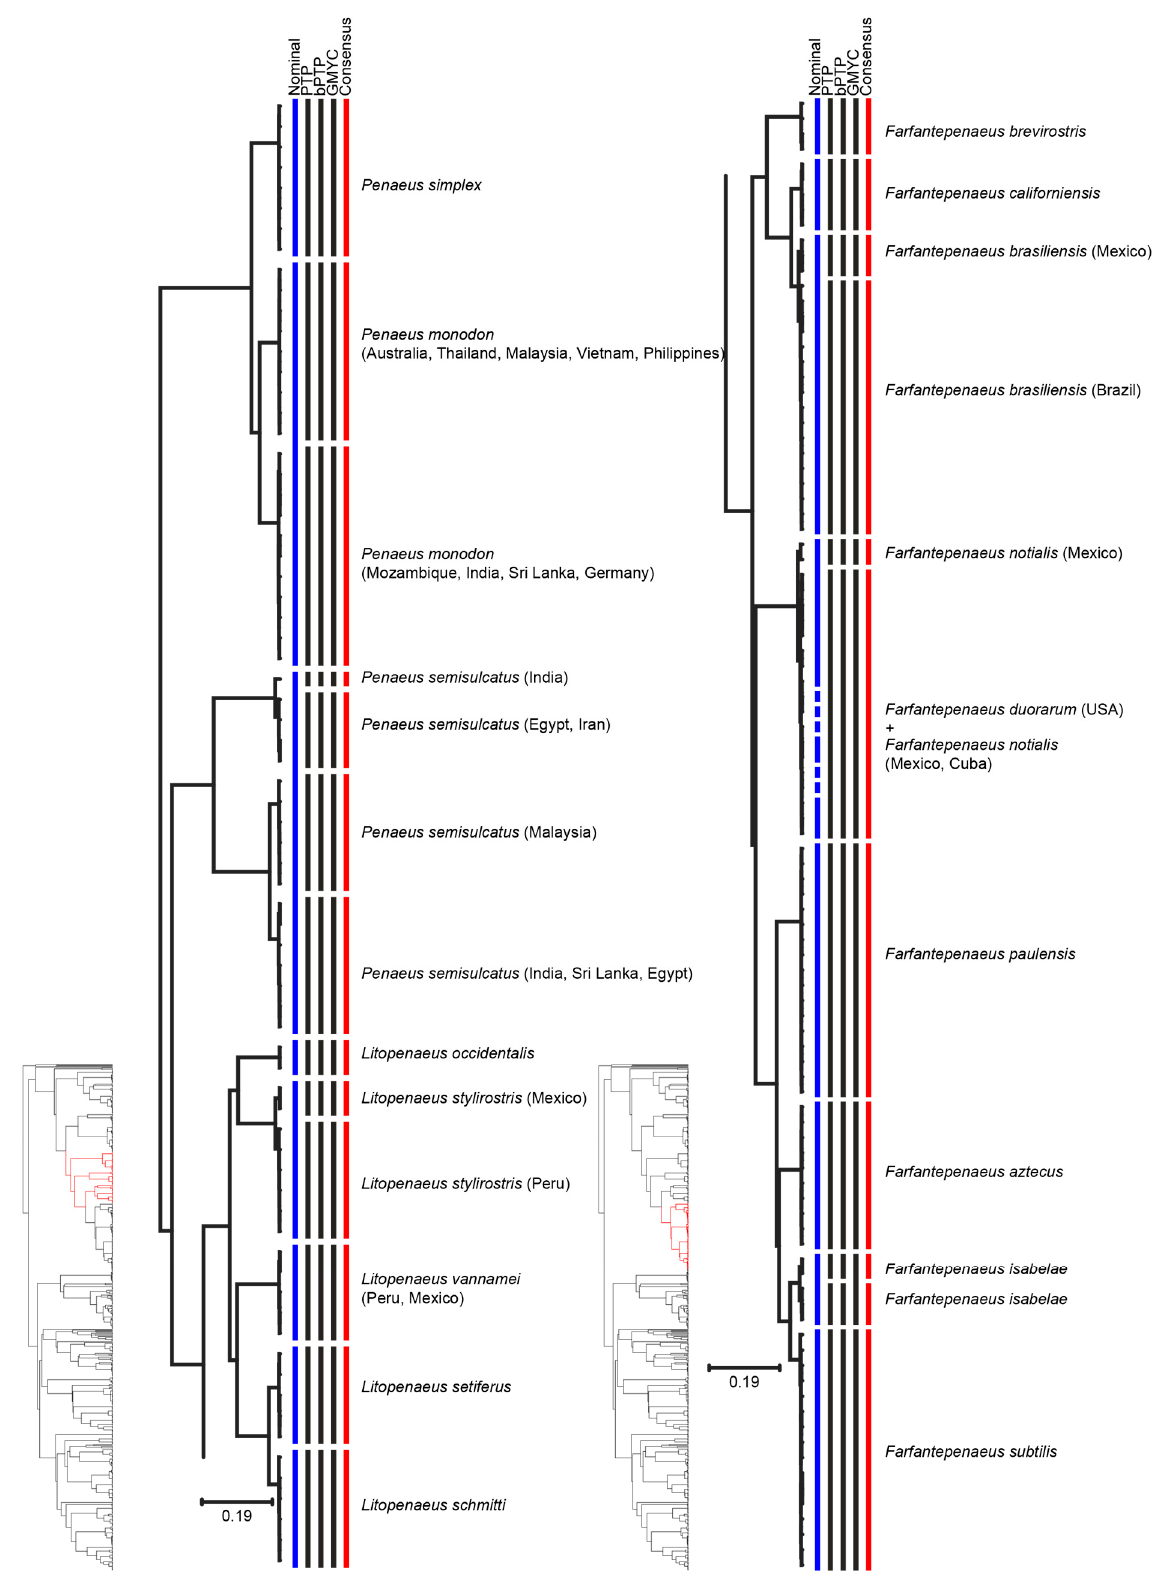
Figure 2. Bayesian tree showing the clustering of the MOTUs obtained by the species delimitation analyses for the genera Farfantepenaeus , Litopenaeus , and Penaeus .